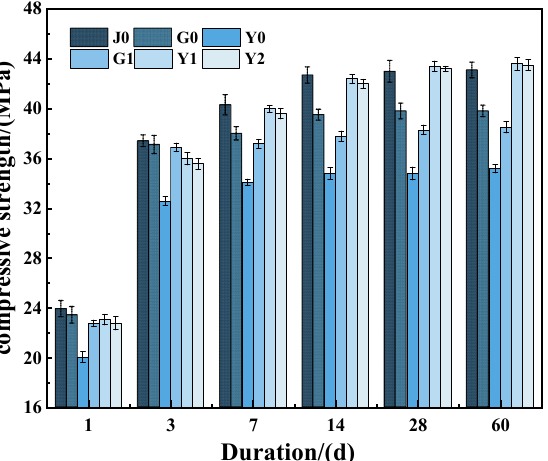
Figure 3. Development of concrete strength under different SAP incorporation methods.